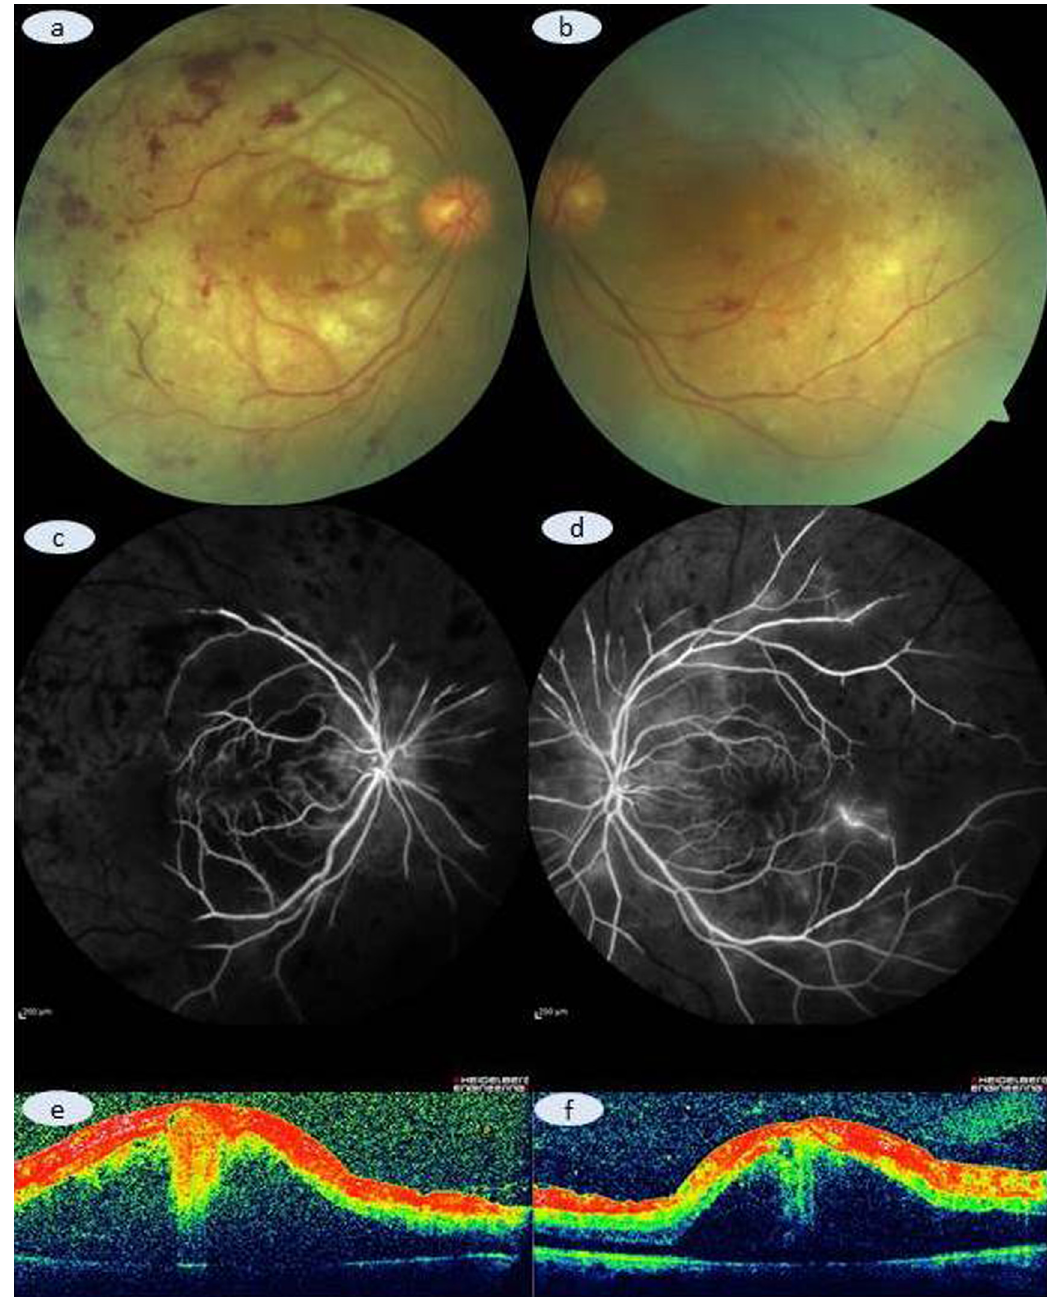
Figure 1: Color fundus picture depicting the whitish appearance of superficial retina with some occluded distal arterioles and some retinal hemorrhages (a: right eye; b: left eye). Venous phase of fluorescein angiogram demonstrating the distal, almost totally occluded arterioles and related capillary hypoperfusion (c: right eye; d: left eye). Optical coherence tomograhy disclosing superficial hyperreflective dots to ganglion layer infarct and severe macular edema (e: right eye; f: left